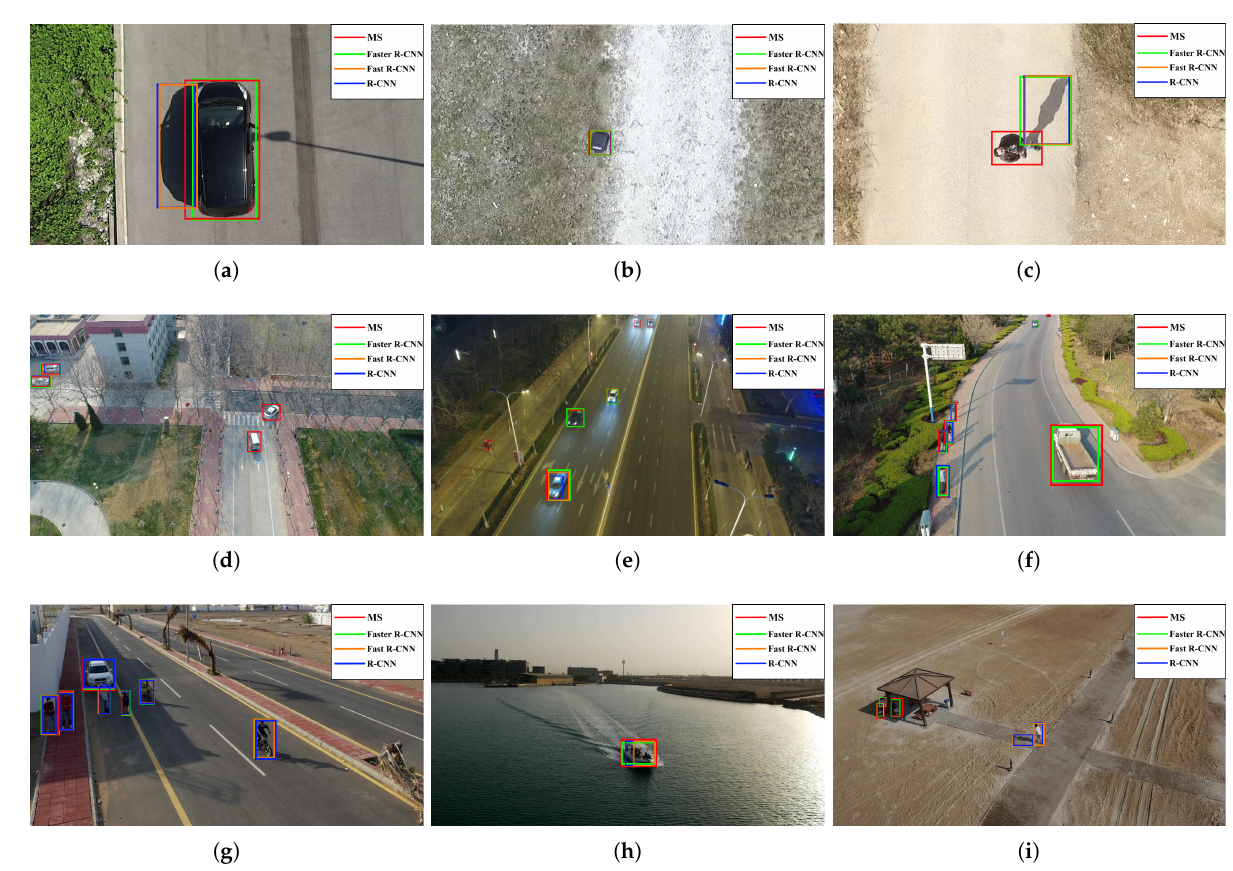
Figure 7. Some comparison images resulting from the object detection task. Results from UMCD, UAVDT, and UAV123 are shown, respectively, on the first, second, and third row. The red, green, orange, and blue bounding boxes are generated, respectively, by the proposed MS model, standard Faster R-CNN, Fast R-CNN, and simple R-CNN algorithms. The elements to detect within the several scenes are: a vehicle ( a , d – g ), a person ( c , e – g , i ), a suitcase ( b ), and a boat ( h